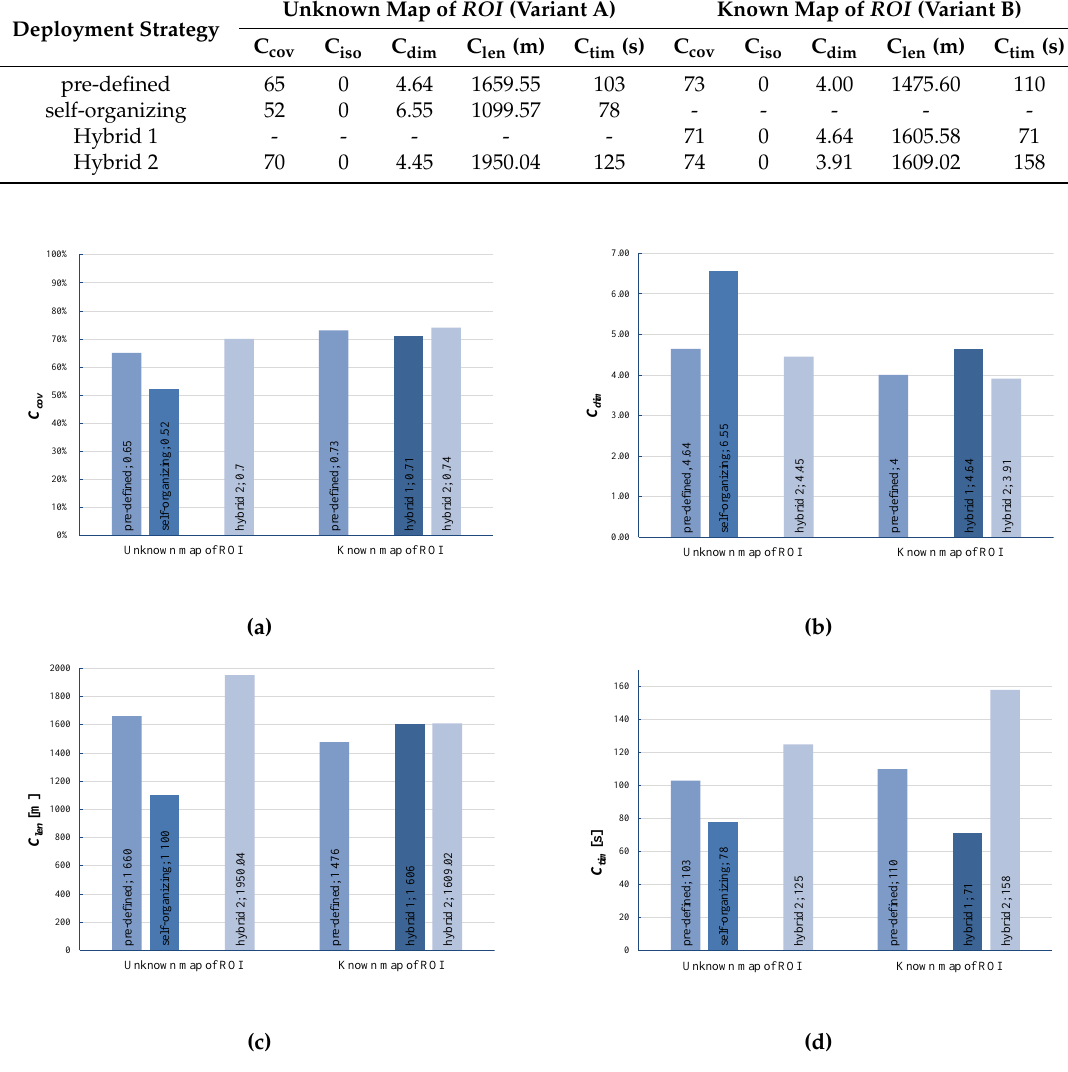
Figure 5. Comparison of the metrics values for pre-defined, self-organizing and hybrid deployment strategies applied in Scenario 1: ( a ) compact coverage; ( b ) average network node degree; ( c ) path length of mobile platforms; ( d ) time of